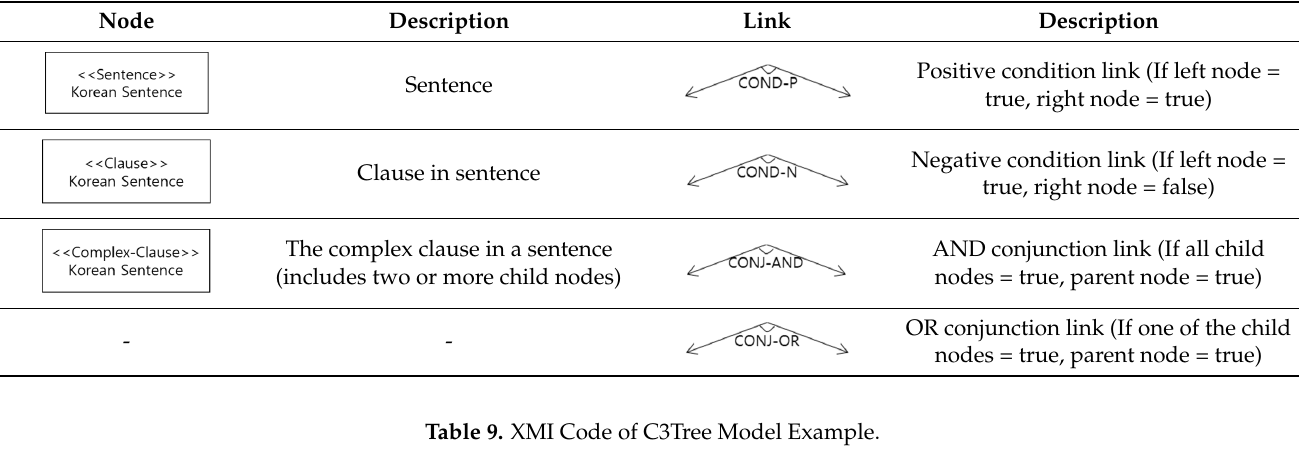
Table 9. XMI Code of C3Tree Model Example.